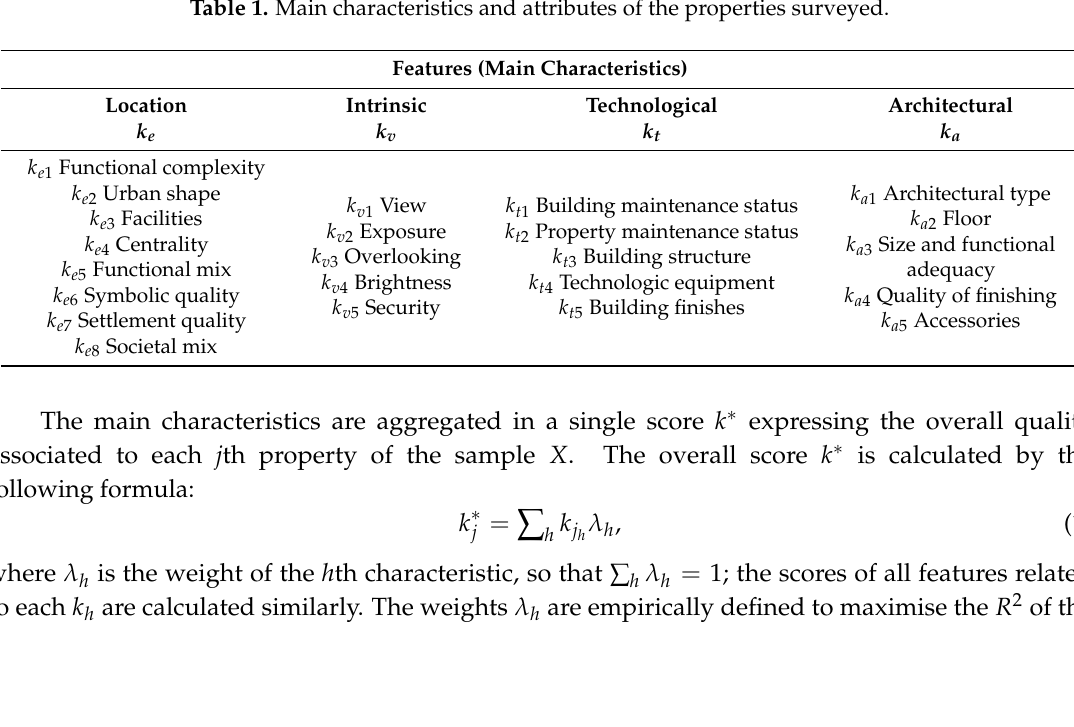
Table 1. Main characteristics and attributes of the properties